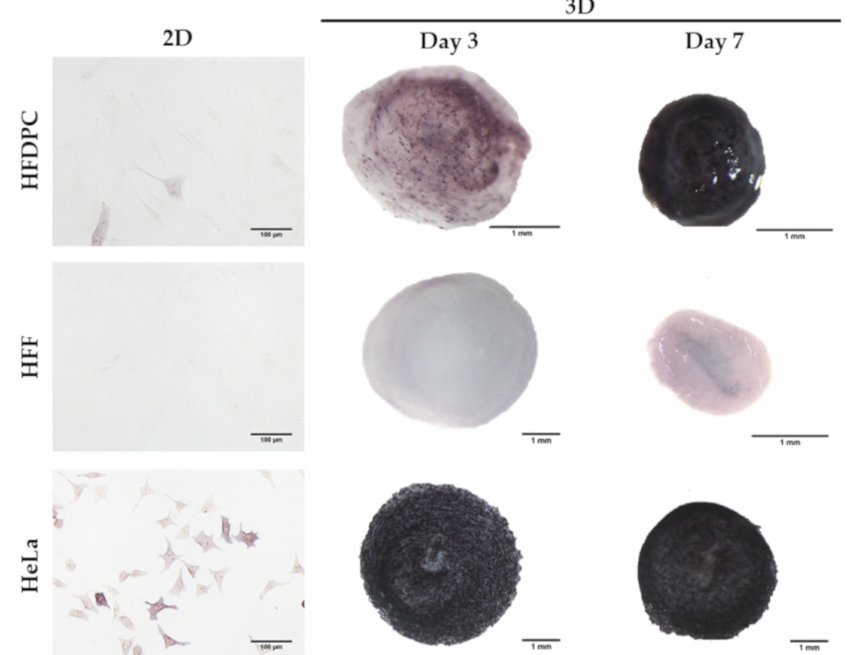
Figure 5. Alkaline phosphatase staining in 2D and 3D cultures. HFDPC were negatively stained for ALP activity in 2D cultures. The expression of ALP was recovered once encapsulated in RAD16-I 3D sca ff olds. Human Foreskin Fibroblasts (HFF) were used as a negative control and HeLa cells as a positive control for ALP